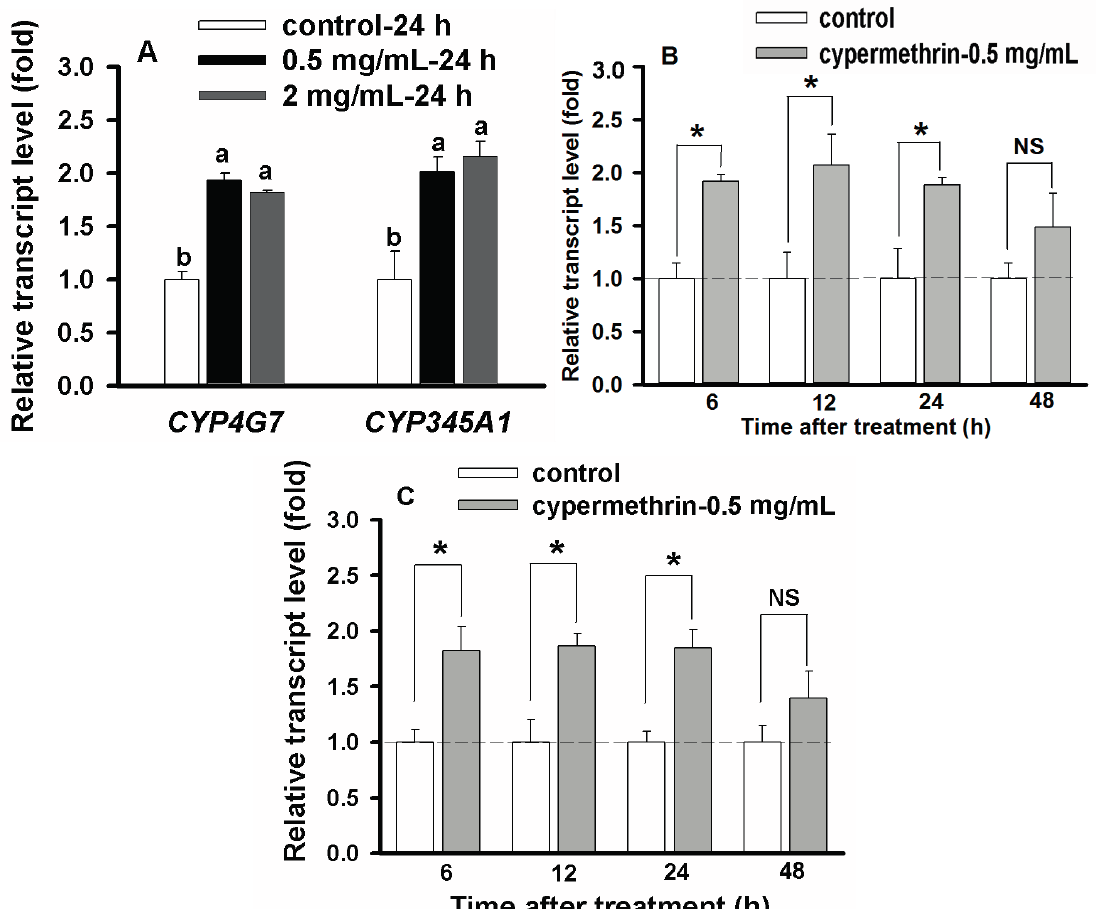
Figure 4. Cypermethrin concentration and time dependent up-regulation of CYP4G7 and CYP345A1 in 20-day larvae. Controls were normalized as 1.0, and the relative transcript levels of CYP genes were calculated based on their corresponding controls. ( A ) Cypermethrin concentration dependent up-regulation as measured at 2 and 0.5 μ g/mL with the exposure time of 24 h. Different letters above the standard error bars indicate significant differences based on the one-way ANOVA followed by Tukey’s HSD multiple comparison test ( p < 0.05); ( B ) Time dependent up-regulation of CYP4G7 by cypermethrin (0.5 μ g/mL) as measured at 6, 12, 24 and 48 h; and ( C ) Time dependent up-regulation of CYP345A1 by cypermethrin (0.5 μ g/mL) as measured at 6, 12, 24 and 48 h. Dash lines represent relative transcript level of the control (larvae treated with the insecticide solvent only) as 1.0. Statistical analysis was conducted to compare the expression levels between the control and the insecticide-treated insects within the same time duration by using Student’s t test. Asterisk above the standard error bars indicates significant difference whereas NS indicates no significant